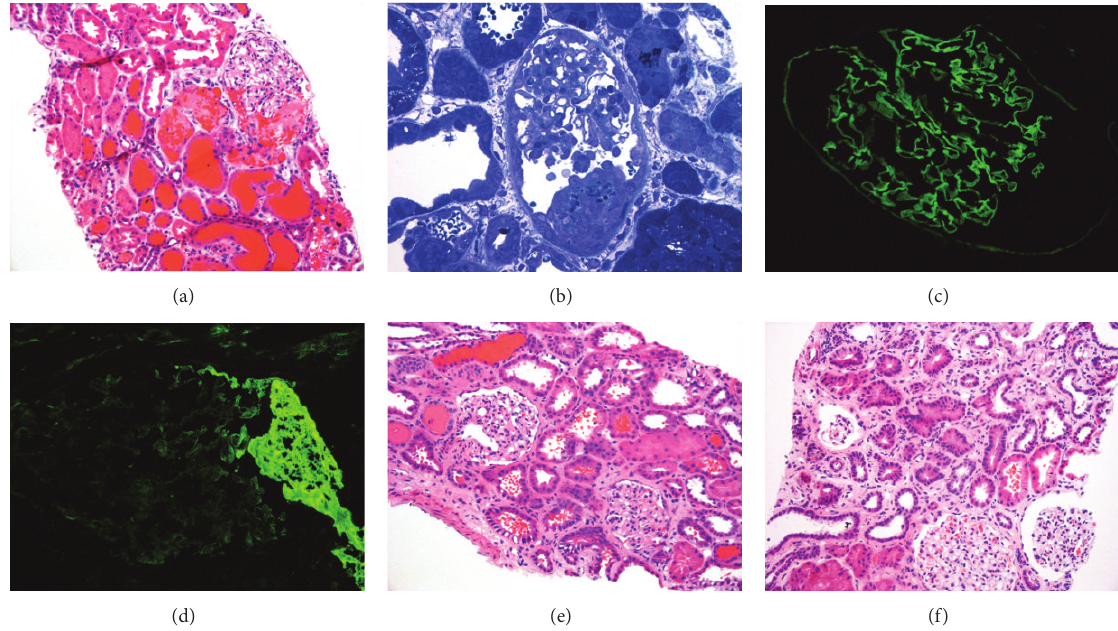
Figure 2: First renal biopsy. (a) Low power view shows a glomerulus with segmental fibrin deposition in the Bowman’s space. There is acute tubular injury with many red blood cell casts (H&E × 200). (b) Toluidine blue stained one-micron-thick section reveals a glomerulus with a small cellular crescent. (c) Immunofluorescence staining shows bright linear staining along the capillary walls for IgG. (d) Immunofluorescence staining discloses a segmental fibrinogen staining indicating necrosis/early crescent. Follow-up renal biopsies. (e) Low power view reveals two unremarkable glomeruli with mild tubular injury and few red blood cell casts (2nd biopsy, H&E × 200). (f) Low power view shows focal mild tubular atrophy and interstitial fibrosis. The glomeruli are largely unremarkable (3rd biopsy; H&E ×